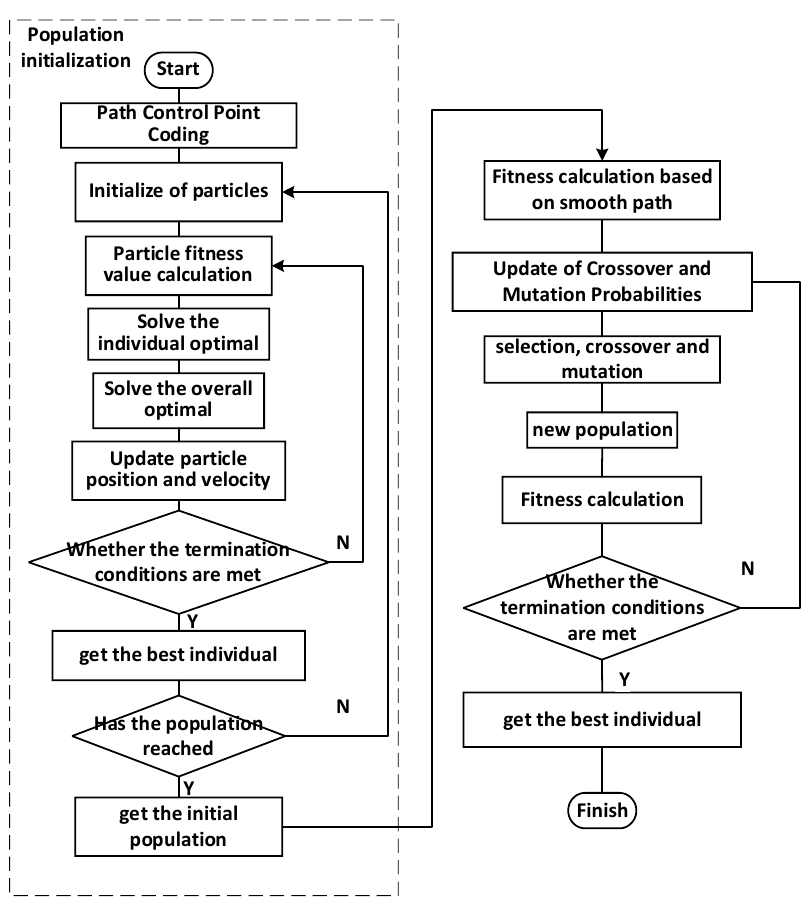
Figure 6. Improvement in the basic process of genetic algorithm path planning.